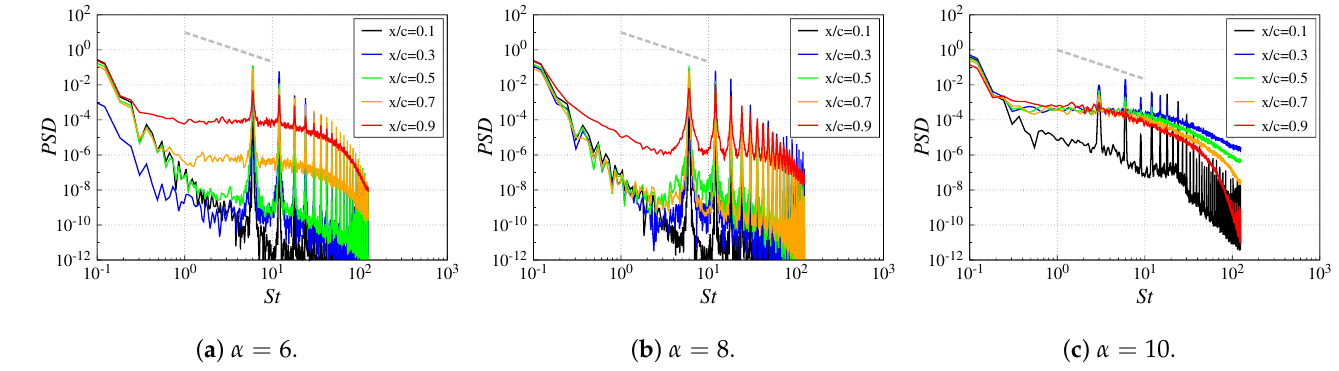
Figure 18. Power spectrum densities (PSDs) of the chordwise velocity fluctuation at the point of the maximum TKE directly above each code length in the Burst